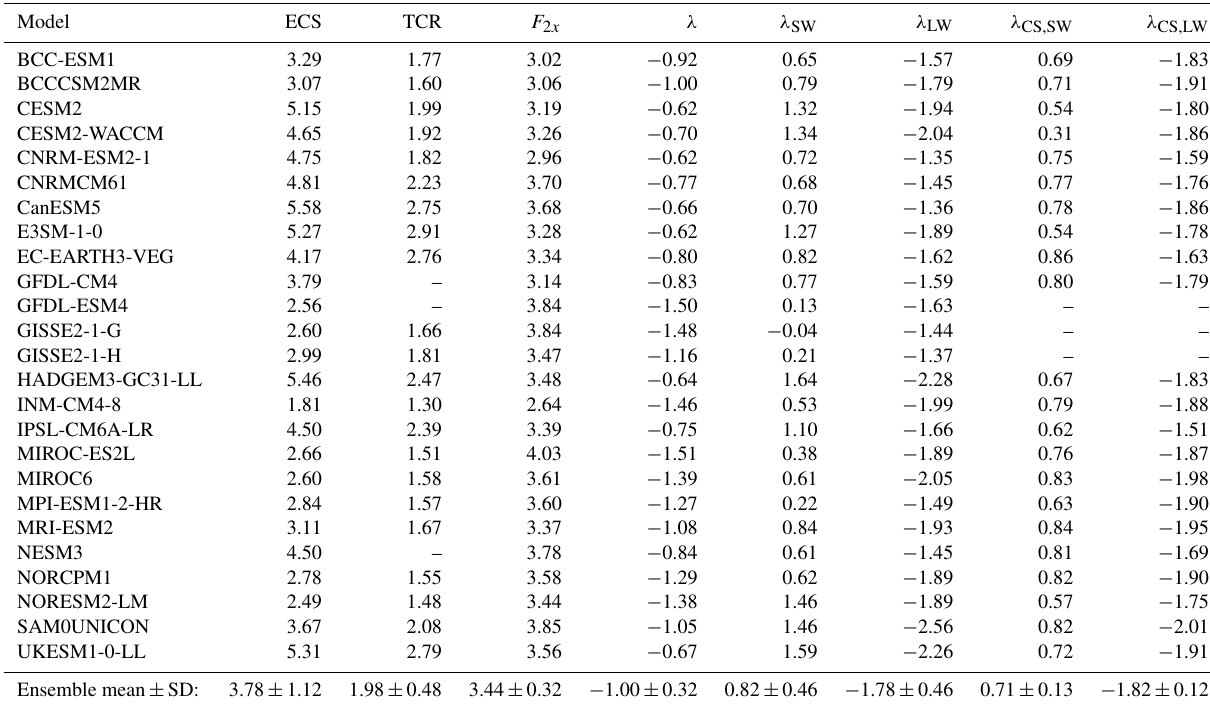
Table 2. List of CMIP6 models and model climate